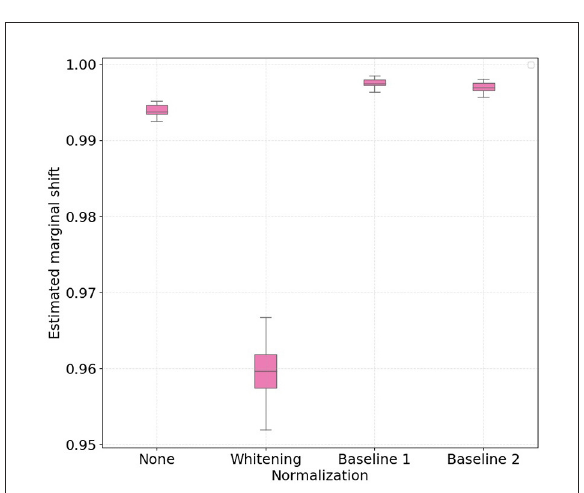
FIGURE6 Boxplots with 30 independent estimates of the aggregate cross-subject marginal shift across different normalization strategies for participants which performed physical activity using a bike . Lower values represent smaller estimated marginal